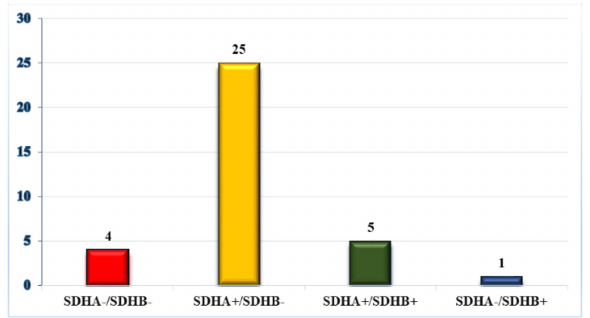
Figure 2. Succinate dehydrogenase A (SDHA) / Succinate dehydrogenase B (SDHB) immunoreactivity for all